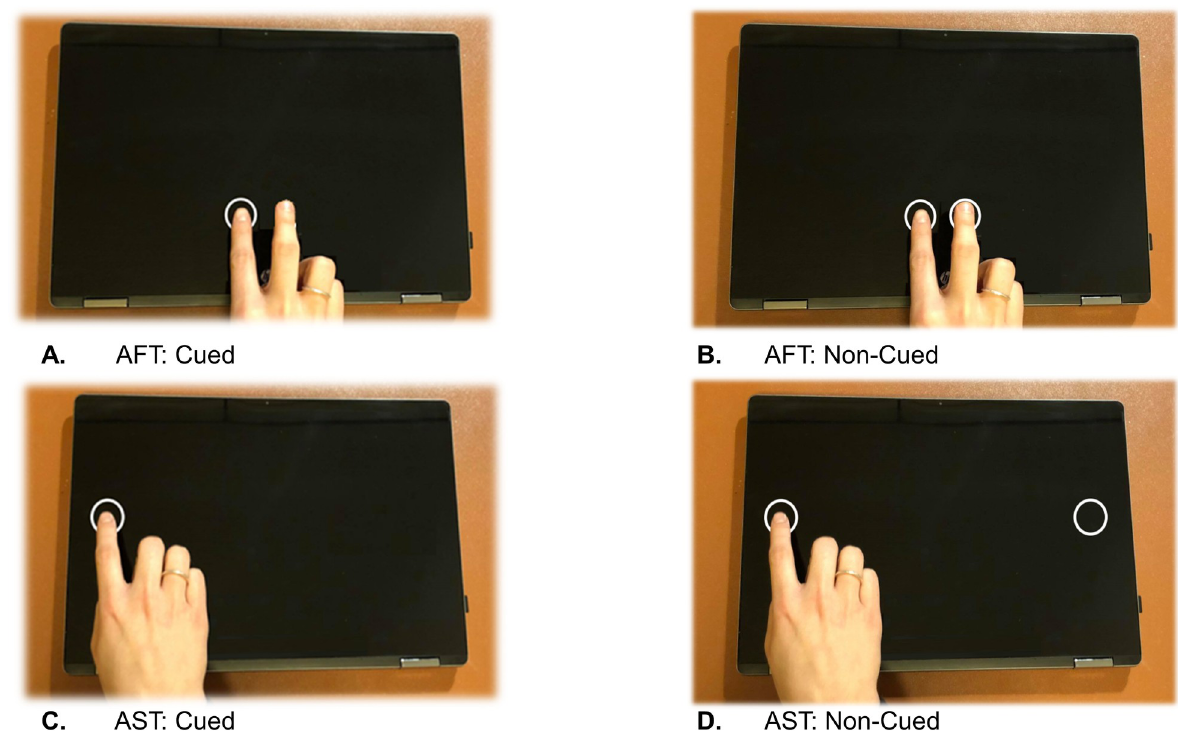
Fig 2. Finger tapping tasks. Figs A and B represent alternate finger tapping configuration (AFT). Figs C and D represent alternate side tapping (AST). In the cued configurations (A & C), the second circle only appears when a tap inside the target was successfully performed. B & D represent the non-cued tapping tasks.